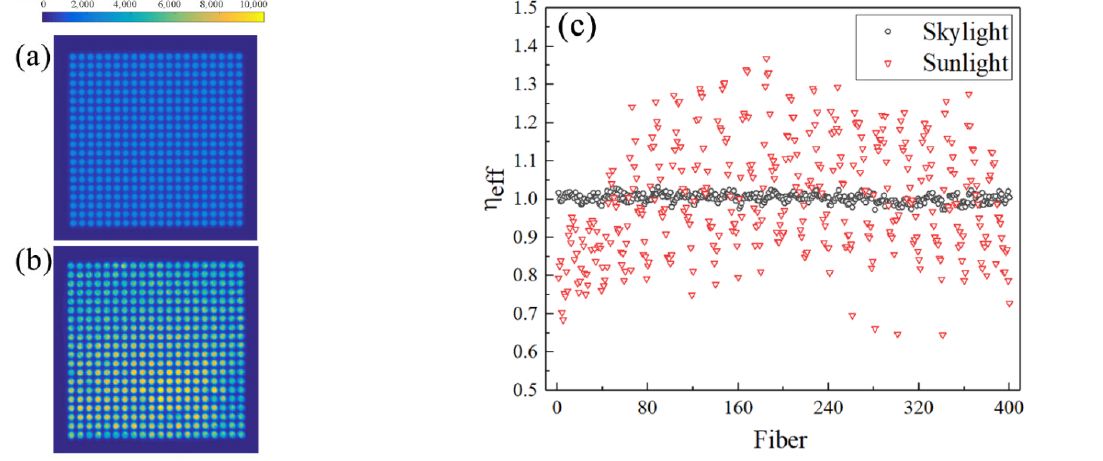
Figure 1. Array spots: ( a ) array spots with skylight; ( b ) array spots with direct sunlight; ( c ) the contrast of the η eff of the two types of spots: the fluctuation of η eff with direct sunlight, as the light source is much larger than that with skylight. The number of the fiber is defined as follows. The number increases one by one in each row in the array from left to right and increases in each column from top to bottom.